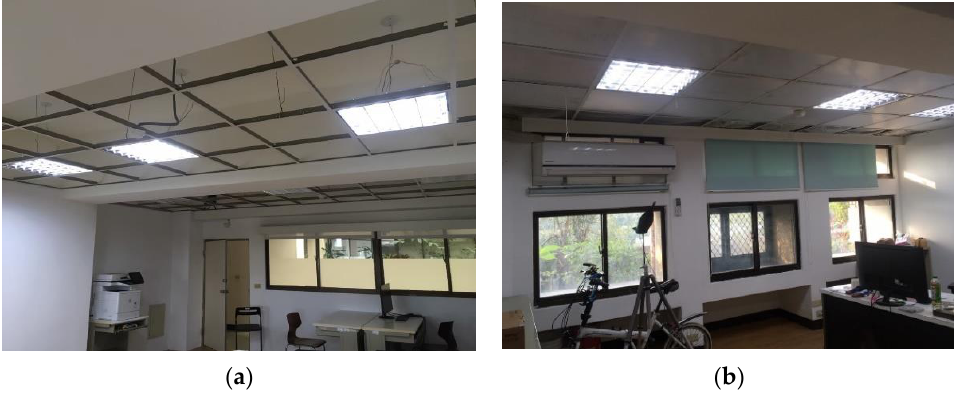
Figure 15. The field measurement office: ( a ) before FEMM installation; and ( b ) after FEMM installation.